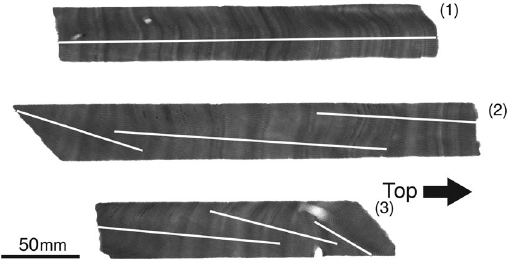
Figure 4. X-radiograph of coral core OMN130221 ( Porites sp .). The white line indicates the measurement lines. Several overlapping measurement lines were sampled to ensuring